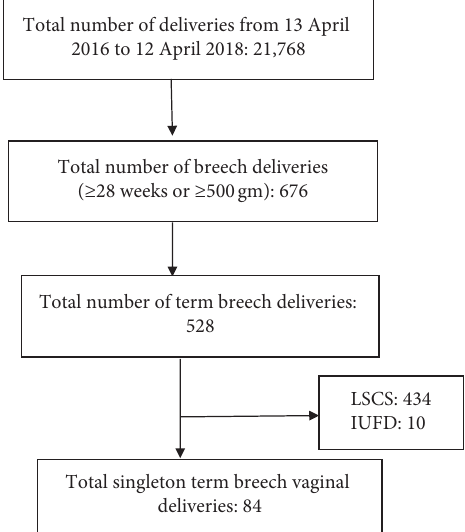
Figure 1: Selection of study